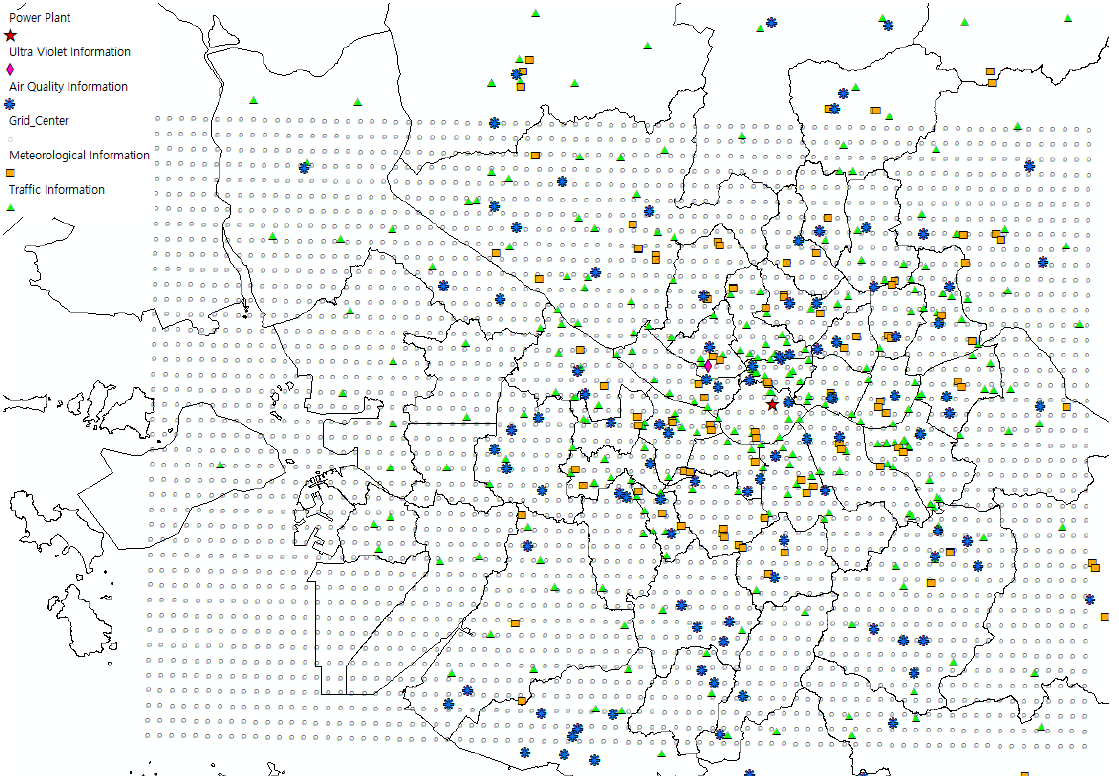
Figure 2. Locations of monitoring sites of each input type. Table 4. The number of missing instances in each air quality